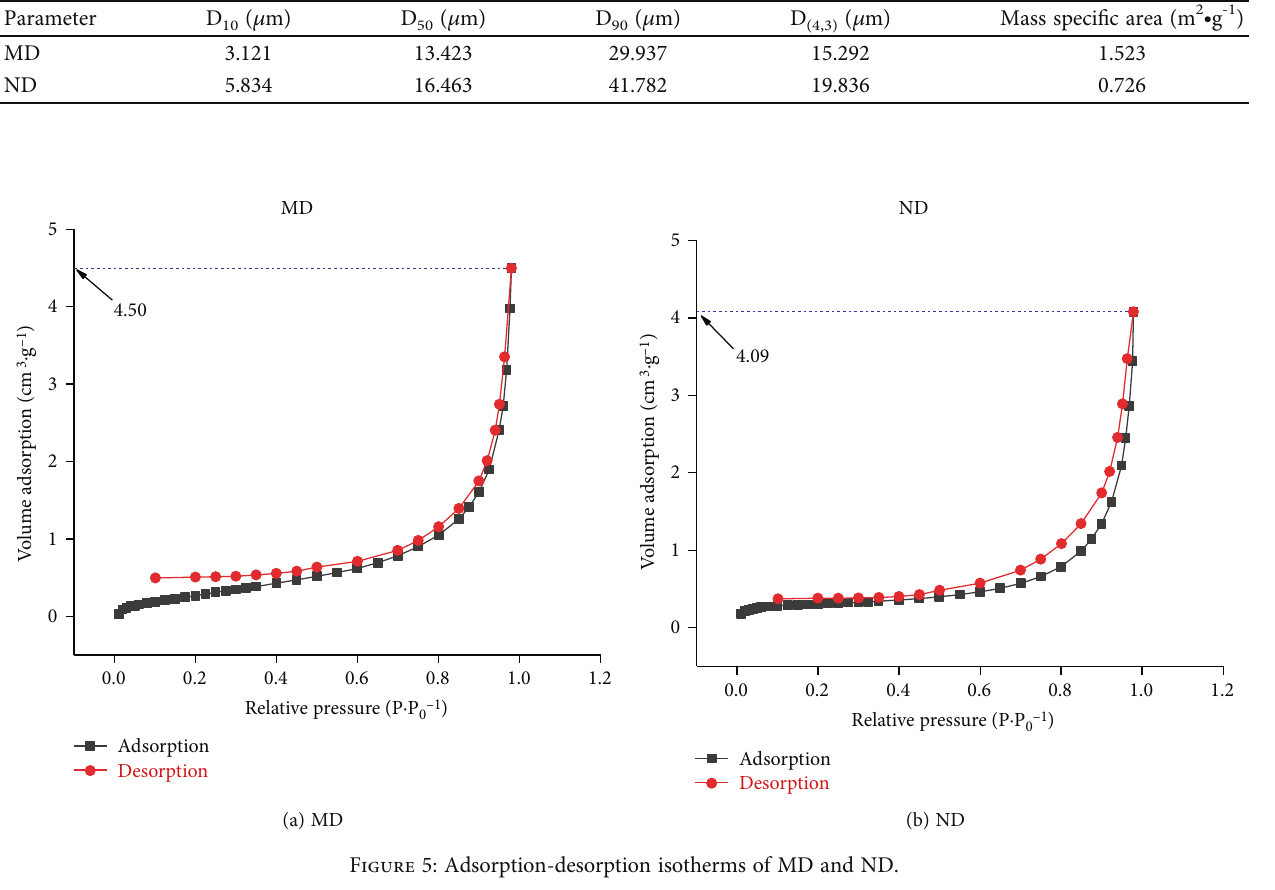
Table 2: Physical parameters of MD and ND.